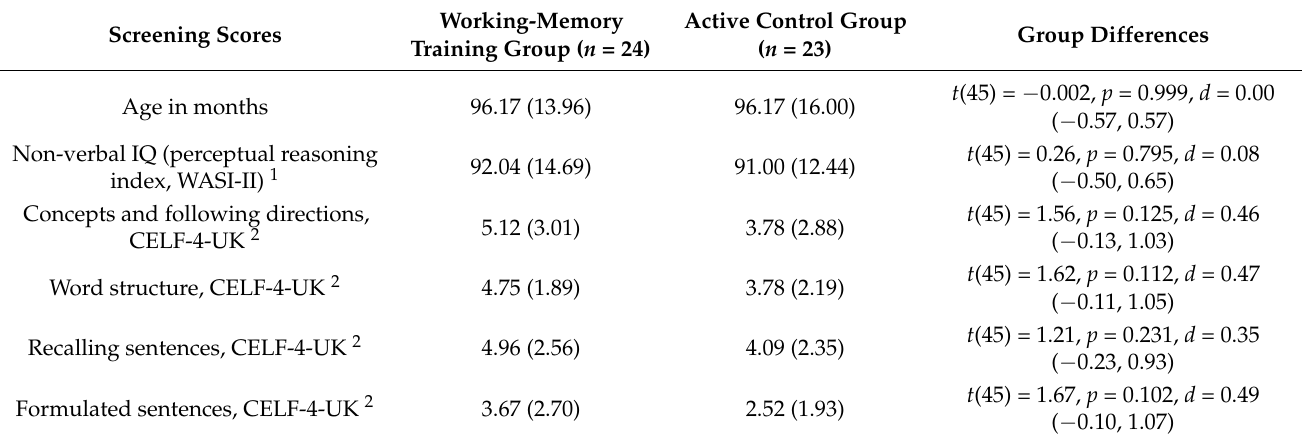
Table 1. Mean screening scores (SD) for children in the working-memory training and active control groups. Independent samples t -tests for group differences are also